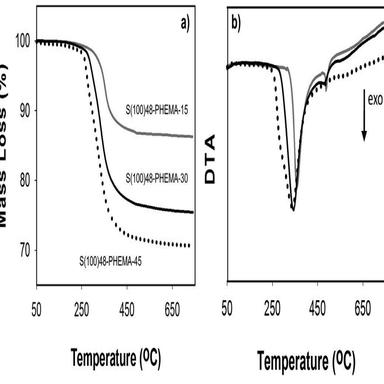
TGA (a) and DTA (b) analyses of S(100)48-PHEMA composite series (as indicated).